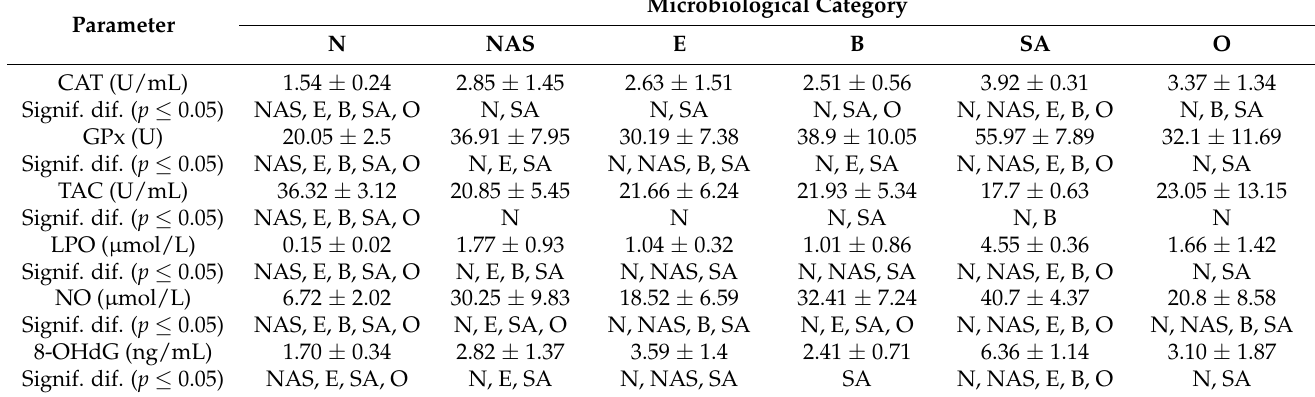
Table 4. Oxidative stress markers results (mean ± SD) by microbiological category based on BLAST analysis of 16S rRNA gene sequence in 76 composite mid-lactation milk samples from Carpathian goats without signs of clinical mastitis in